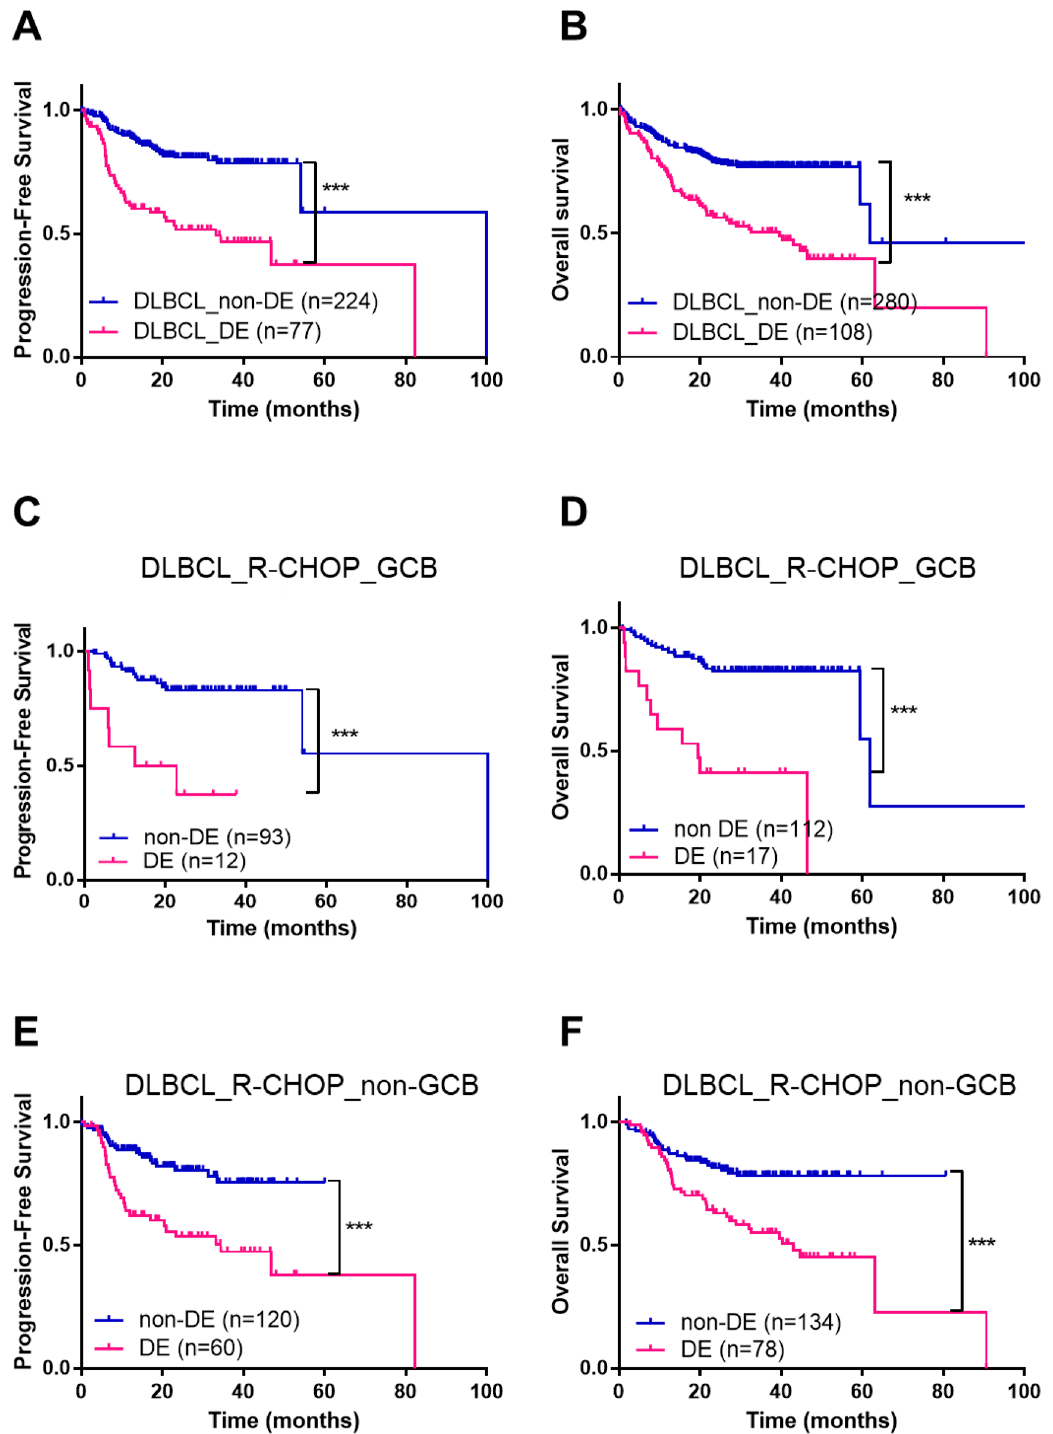
Figure 2. Effect of DE status and COO on the survival of DLBCL patients treated with R-CHOP . Kaplan-Meier curves showing PFS and OS of DLBCL patients according to the DE status ( A , B ). Kaplan-Meier curves showing PFS and OS in R-CHOP-treated DLBCL patients (GCB phenotype) according to the DE status ( C , D ). Kaplan-Meier curves showing PFS and OS of R-CHOP-treated DLBCL patients (non-GCB phenotype) according to the DE status ( E , F ). *** P < 0.001. 2.5. Prognostic Stratification of DE-DLBCL Patients Treated with R-CHOP Univariate Cox survival analysis of DE-DLBCL patients demonstrated that age, poor ECOG PS, elevated serum LDH, involvement of two or more extranodal sites, BM involvement, high IPI score, CD10 expression, and GCB phenotype were associated with poor OS ( P < 0.05 for all; Table S4). To